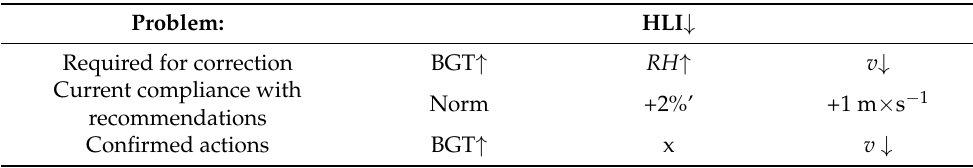
Table 3. Determining factors for